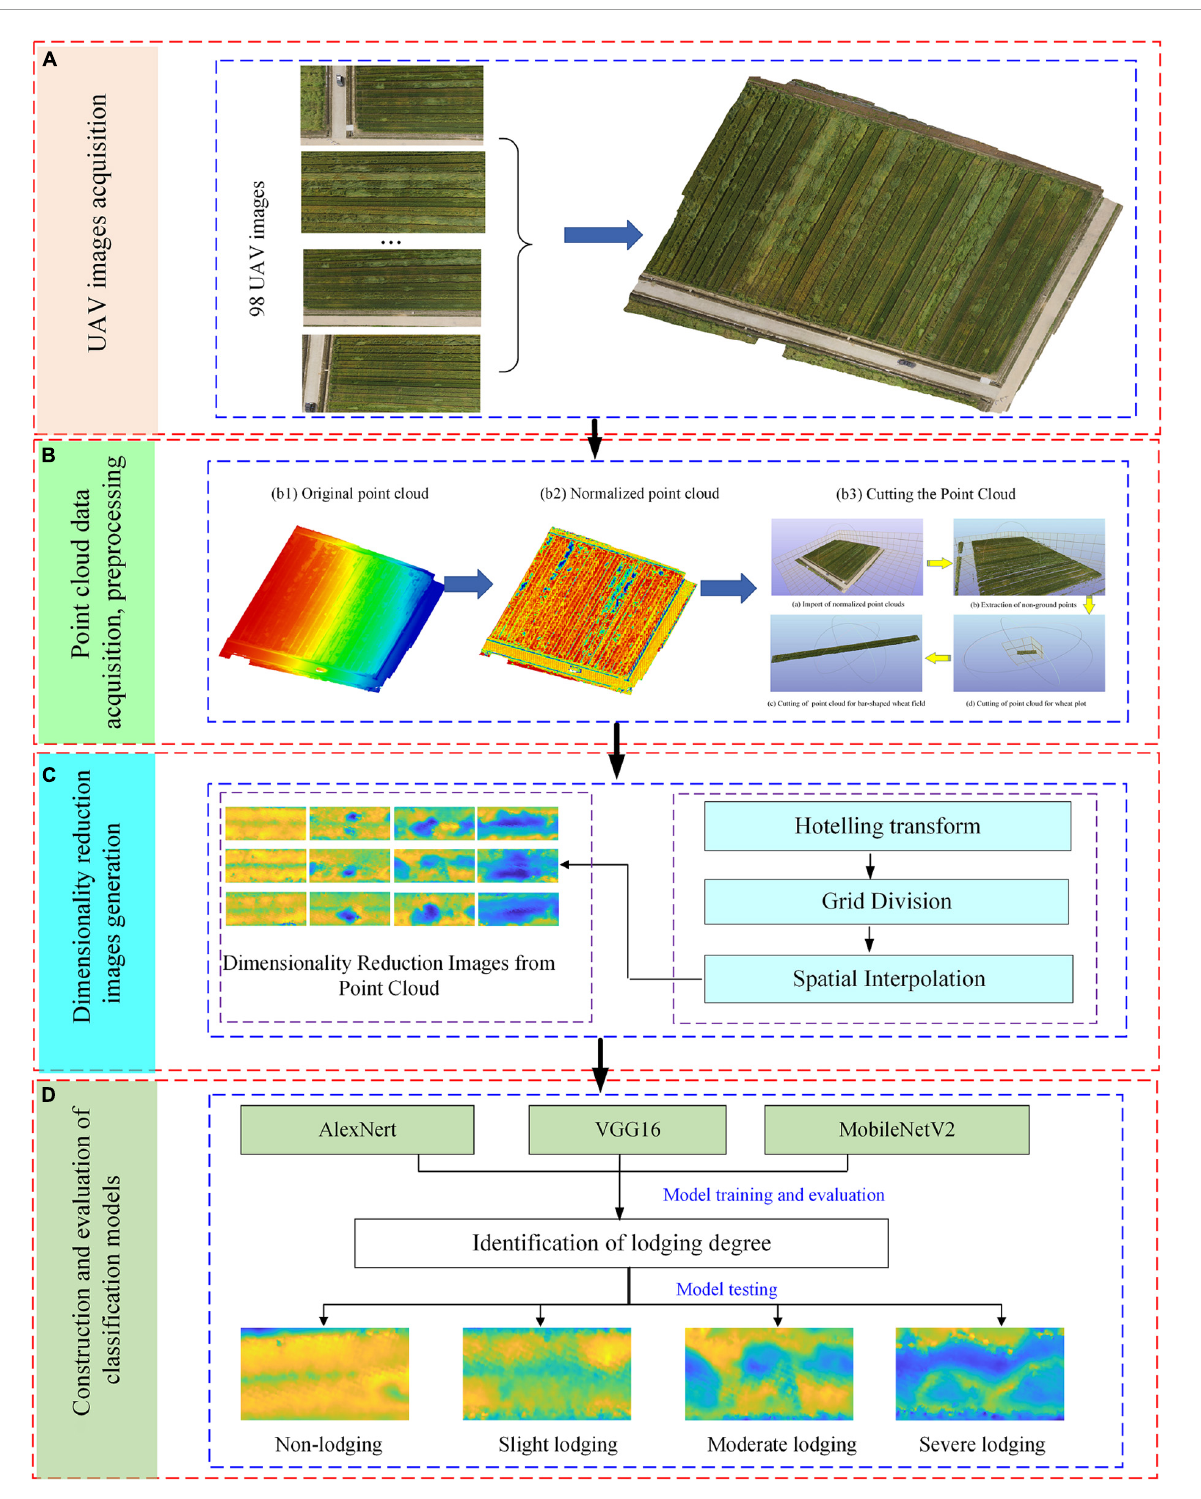
FIGURE3 Flow chart of technical route. (A) UAV images acquisition, (B) point cloud data acquisition, preprocessing, (C) dimensionality reduction images generation, (D) construction and evaluation of classification models.